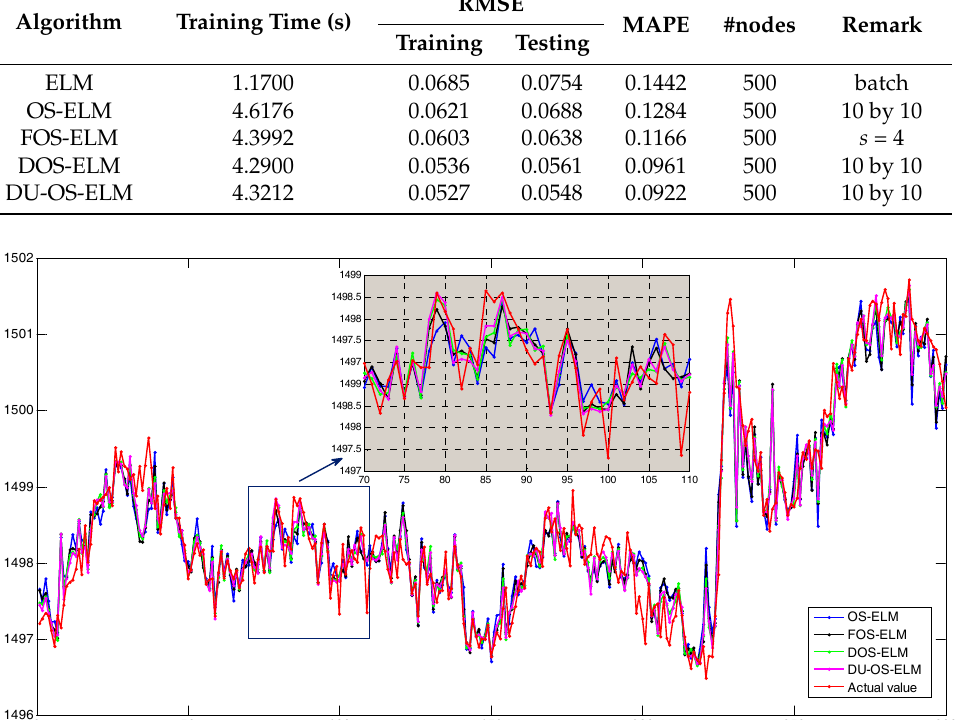
Table A2. Comparison results of different approaches.